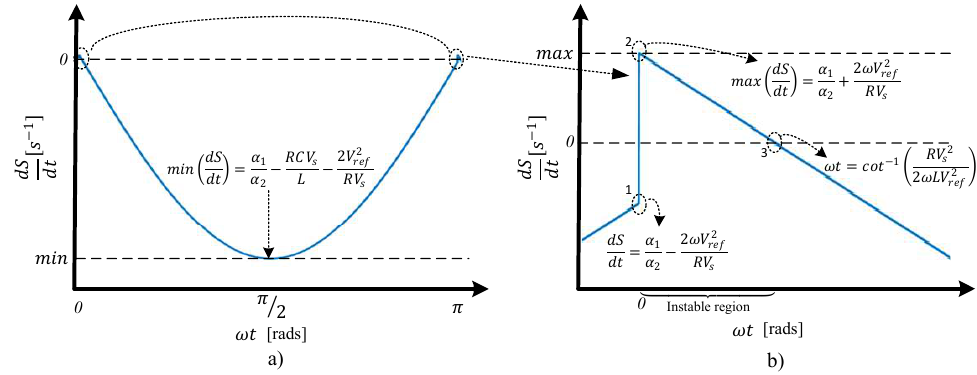
Figure 3. dS / dt for existence condition when u = 1. ( a ) Representation in the range of wt = [ 0, π ] ; ( b ) Zoom in at wt = 0 and wt = π